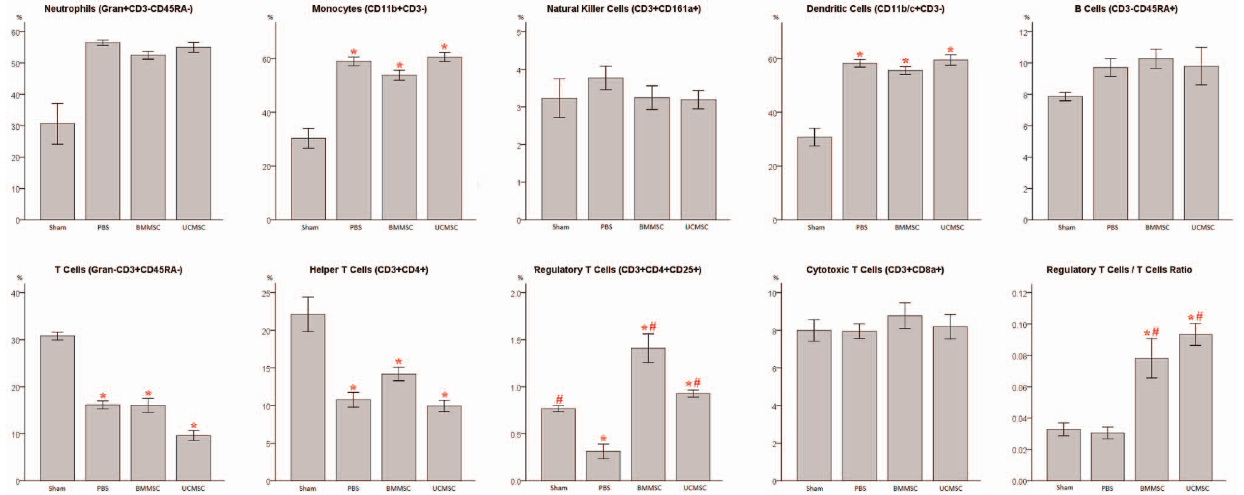
Figure 4. Analysis of peripheral blood mononulcear cells in rats 18 hours after CLP. Compared with sham-operated rats, the percentages of circulating CD11b + CD3- monocytes and CD11b/c + CD3- dendritic cells were elevated in rats undergoing CLP (i.e. BMMSC, UCMSC and PBS groups). Compared with rats receiving PBS only after CLP, the percentage of circulating CD3 + CD4 + CD25 + Treg cells was significantly higher in rats receiving BMMSCs or UCMSCs after CLP, and so was the ratio of Treg cells/T cells. There were no significant differences in these two parameters between rats of BMMSC and UCMSC groups. Data are presented as mean 6 SEM. n=6–9 rats/group. * p , 0.05 versus sham control group. # p , 0.05 versus PBS group.